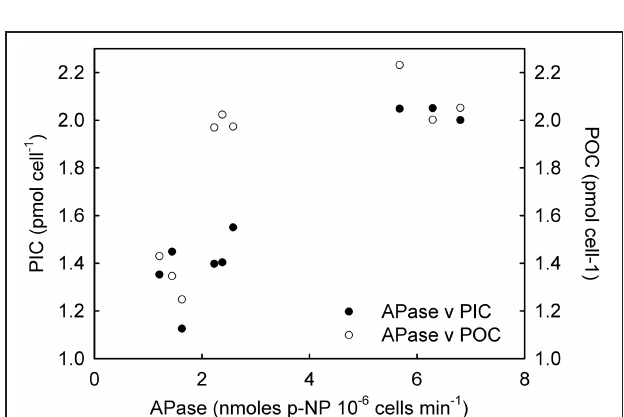
FIGURE 3 | Correlation of alkaline phosphatase (APase) with particulate organic carbon (POC) and particulate inorganic carbon (PIC) under phosphorus limited conditions.